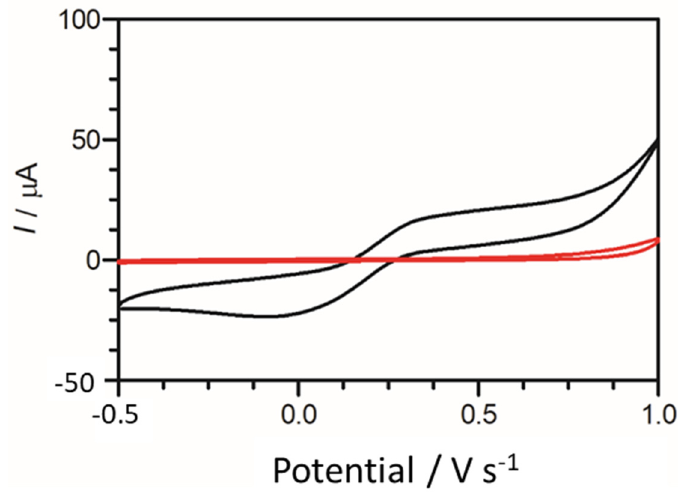
Figure 4. Cyclic voltammogram obtained using an unmodified carbon SPE (red scan) in the presence of 30 µ g/mL of cadaverine solution in Britton–Robinson buffer at a scan rate of 100 mV s − 1 . Potential window − 0.5 to 1.0 V s − 1 vs. Ag/AgCl reference electrode. Cyclic voltammogram of cadaverine recorded utilising a C-MWCNT/DAO/EDC-NHS/GA working electrode vs. Ag/AgCl reference electrode (black scan) at a scan rate of 100 mV s − 1 .